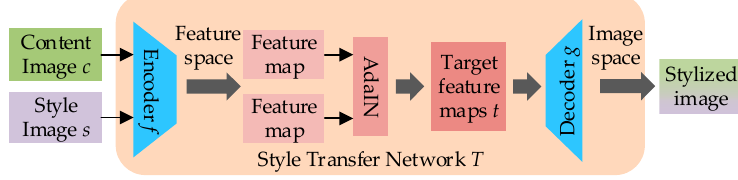
Figure 2. Style transfer algorithm.